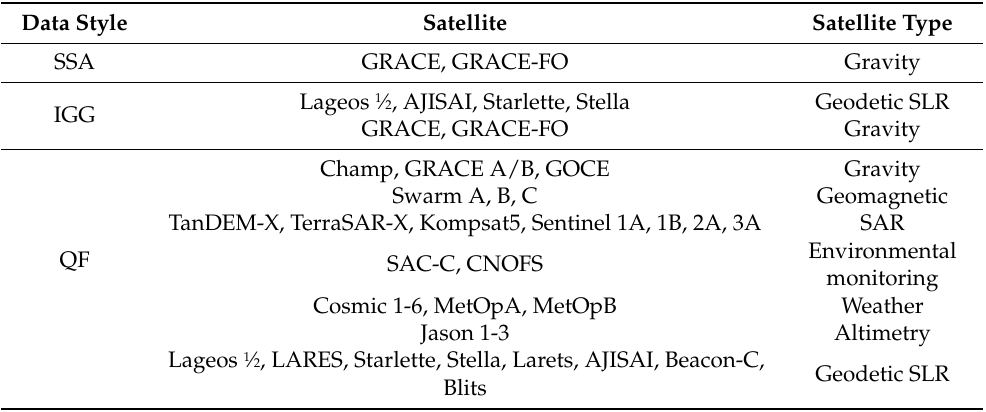
Table 1. The HLSST LEO satellites, SLR, and low-low satellite-to-satellite tracking (LLSST) satellites used for obtaining the SSA, IGG, and QF